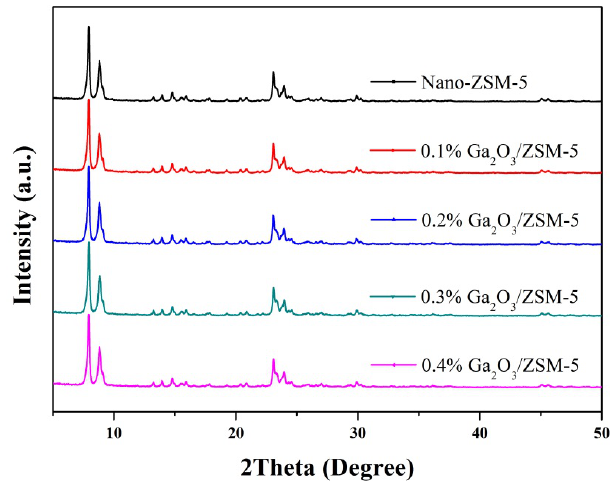
Figure 1. XRD patterns of the as-synthesized Ga 2 O 3 /ZSM-5 and Nano-ZSM-5.